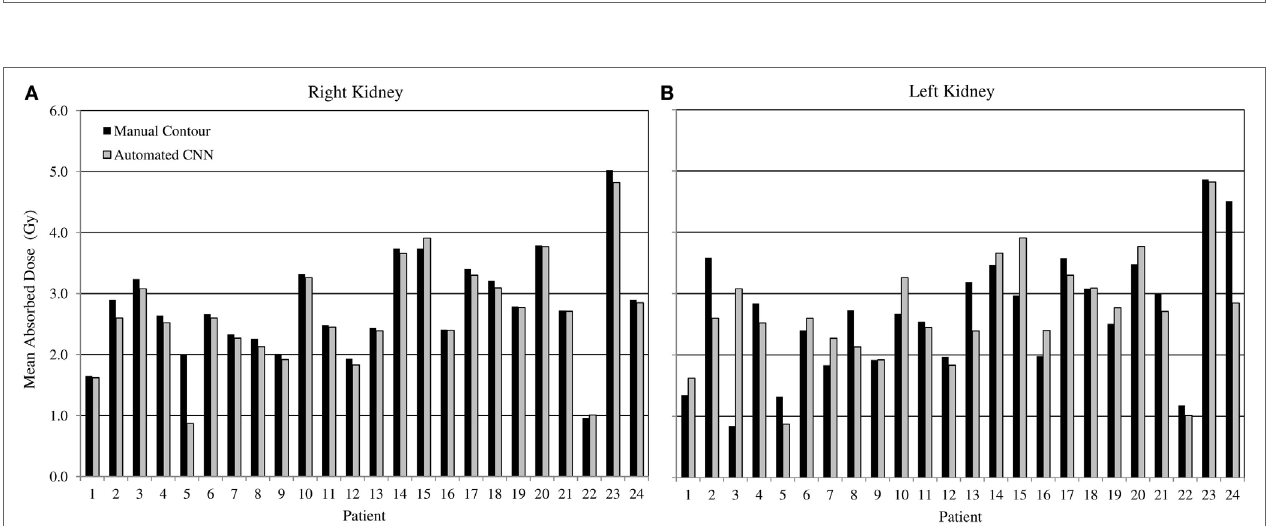
FigUre 5 | Results of automated (red) and manual (blue) segmentation overlaid with maximum intensity projections of voxel dose volumes. Patients 2 and 5 show some disagreement in cystic regions of kidney. In patients 6, 23, and 24 a small volume of bowel is captured by the automated